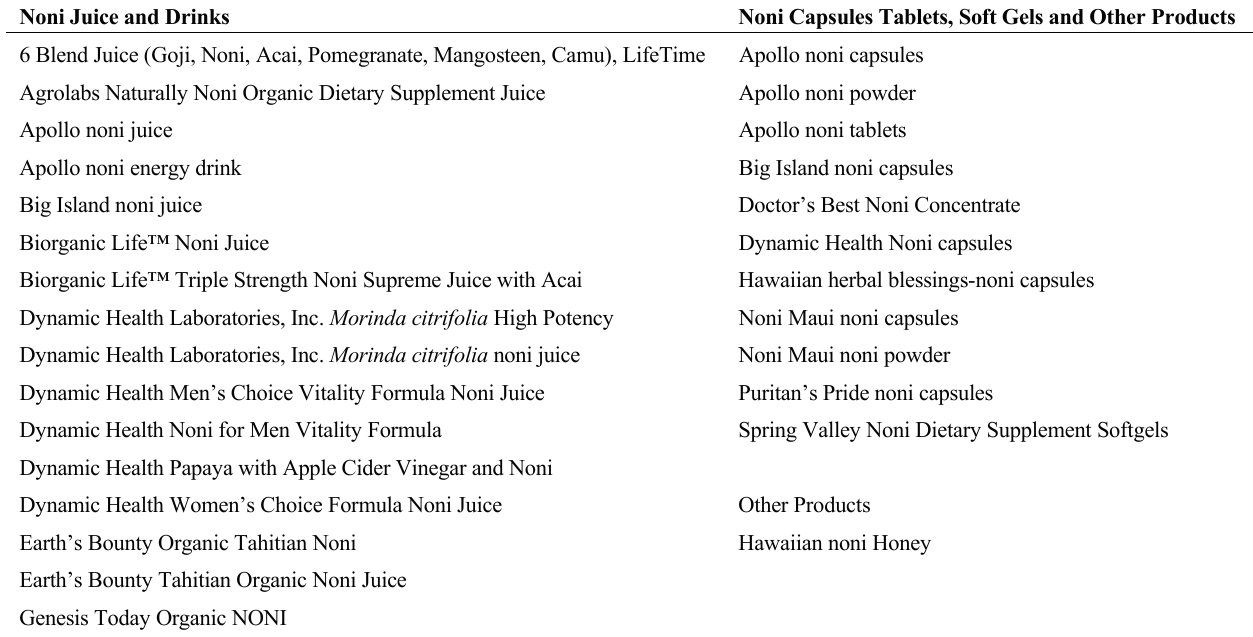
Table A2. Commercial noni